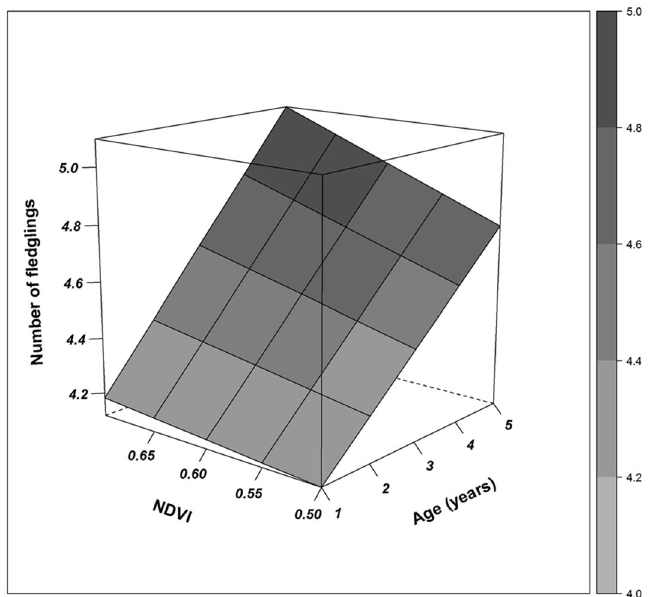
Figure 4. Three-dimensional surface plot showing the relationship between age, NDVI from winter areas and the number of fledglings produced by females at the first brood. Lines and grey scale represent predicted values obtained after calculating the indirect effect of the interaction between age and NDVI on the number of fledglings. This indirect effect was calculated by multiplying standardized path coefficients connecting the interaction term with the final reproductive success.